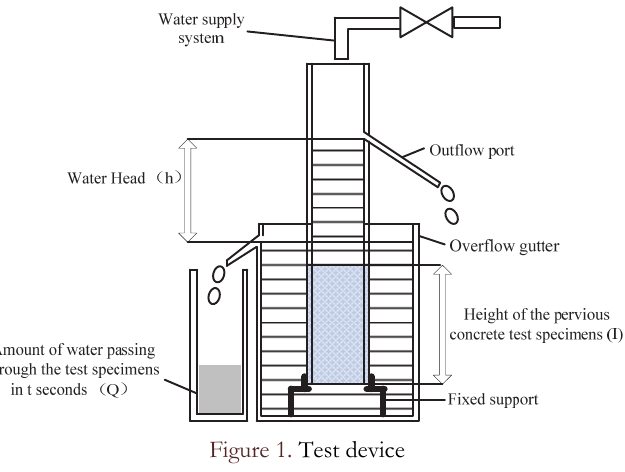
Figure 1. Test device